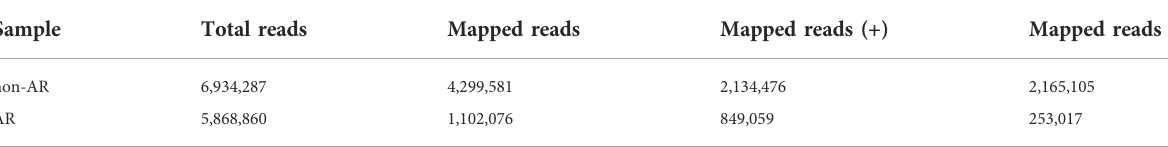
TABLE 2 Reads mapping to the reference sequence.